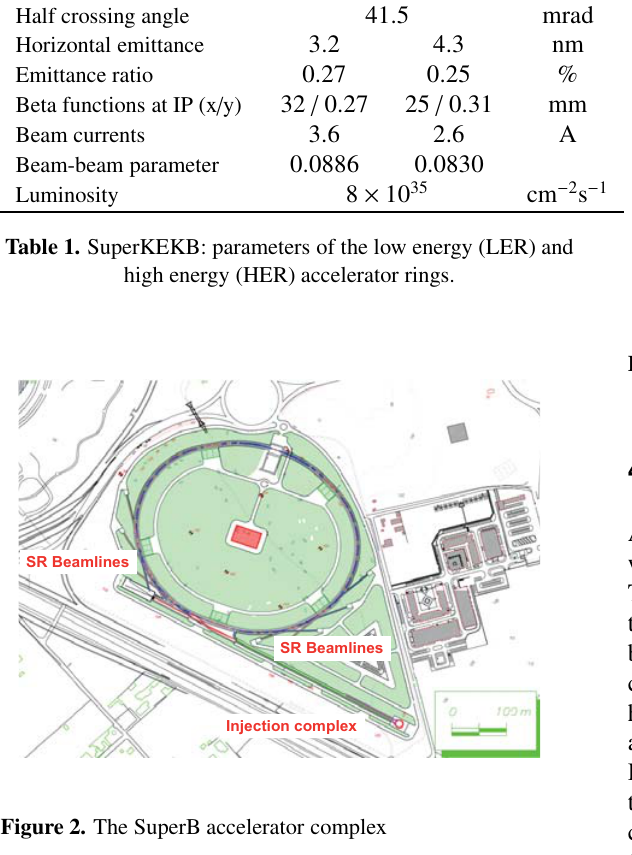
the RF system, and a completely redesigned interaction region [18].